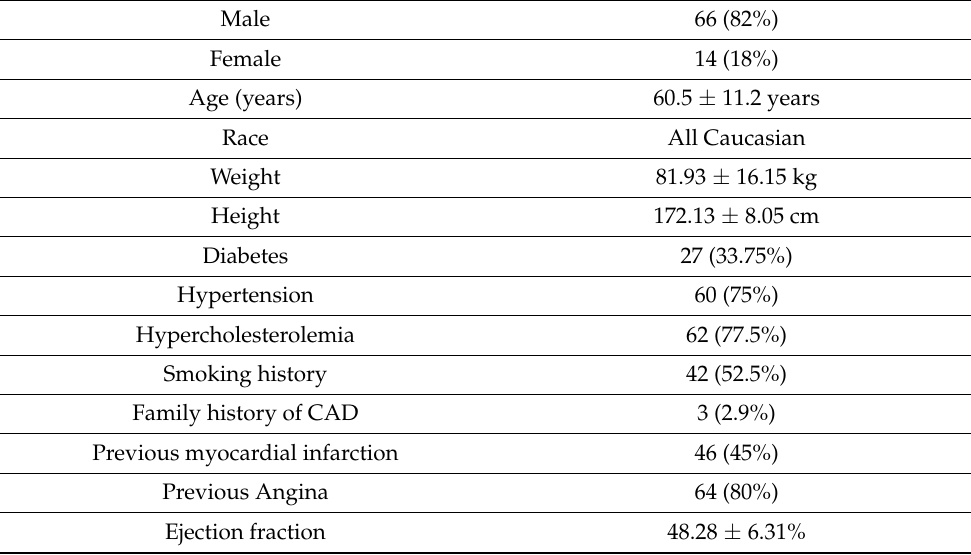
Table 1. Baseline patient characteristics and risk factors ( n = 80).